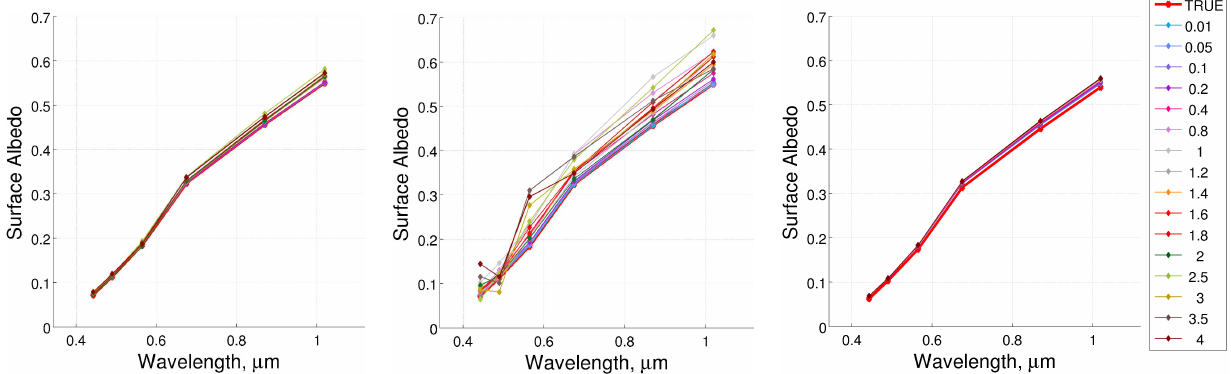
Fig. 15. Retrieval of surface albedo over Banizoumbou for 16 different aerosol loadings from τ (0.44µm)=0.01 to 4.0: (left panel) single- pixel retrieval with no noise added; (center panel) single-pixel retrieval with the random noise added; (right panel) multi-pixel retrieval with the random noise